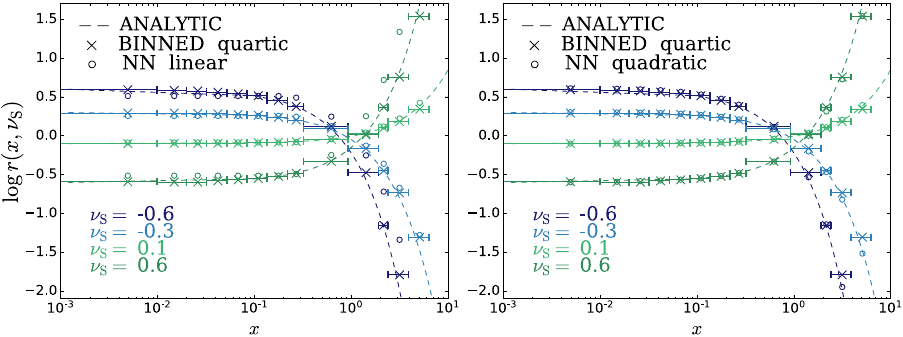
Fig. 2 The dependence on ν s of log N b (ν s )/ N b ( 0 ) in selected bins. The dots represent the true value of the log-ratio. The linear, quadratic and quartic fits are performed using a subset of the true values points as explained in the main text